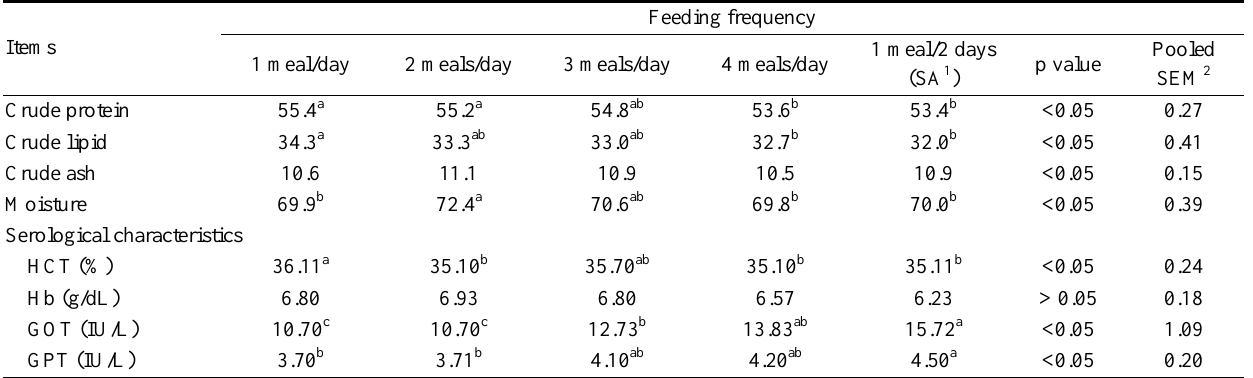
Table 2. Whole-body proximate composition and serological characteristics of 92 g Korean rockfish, reared at 15°C water temperature